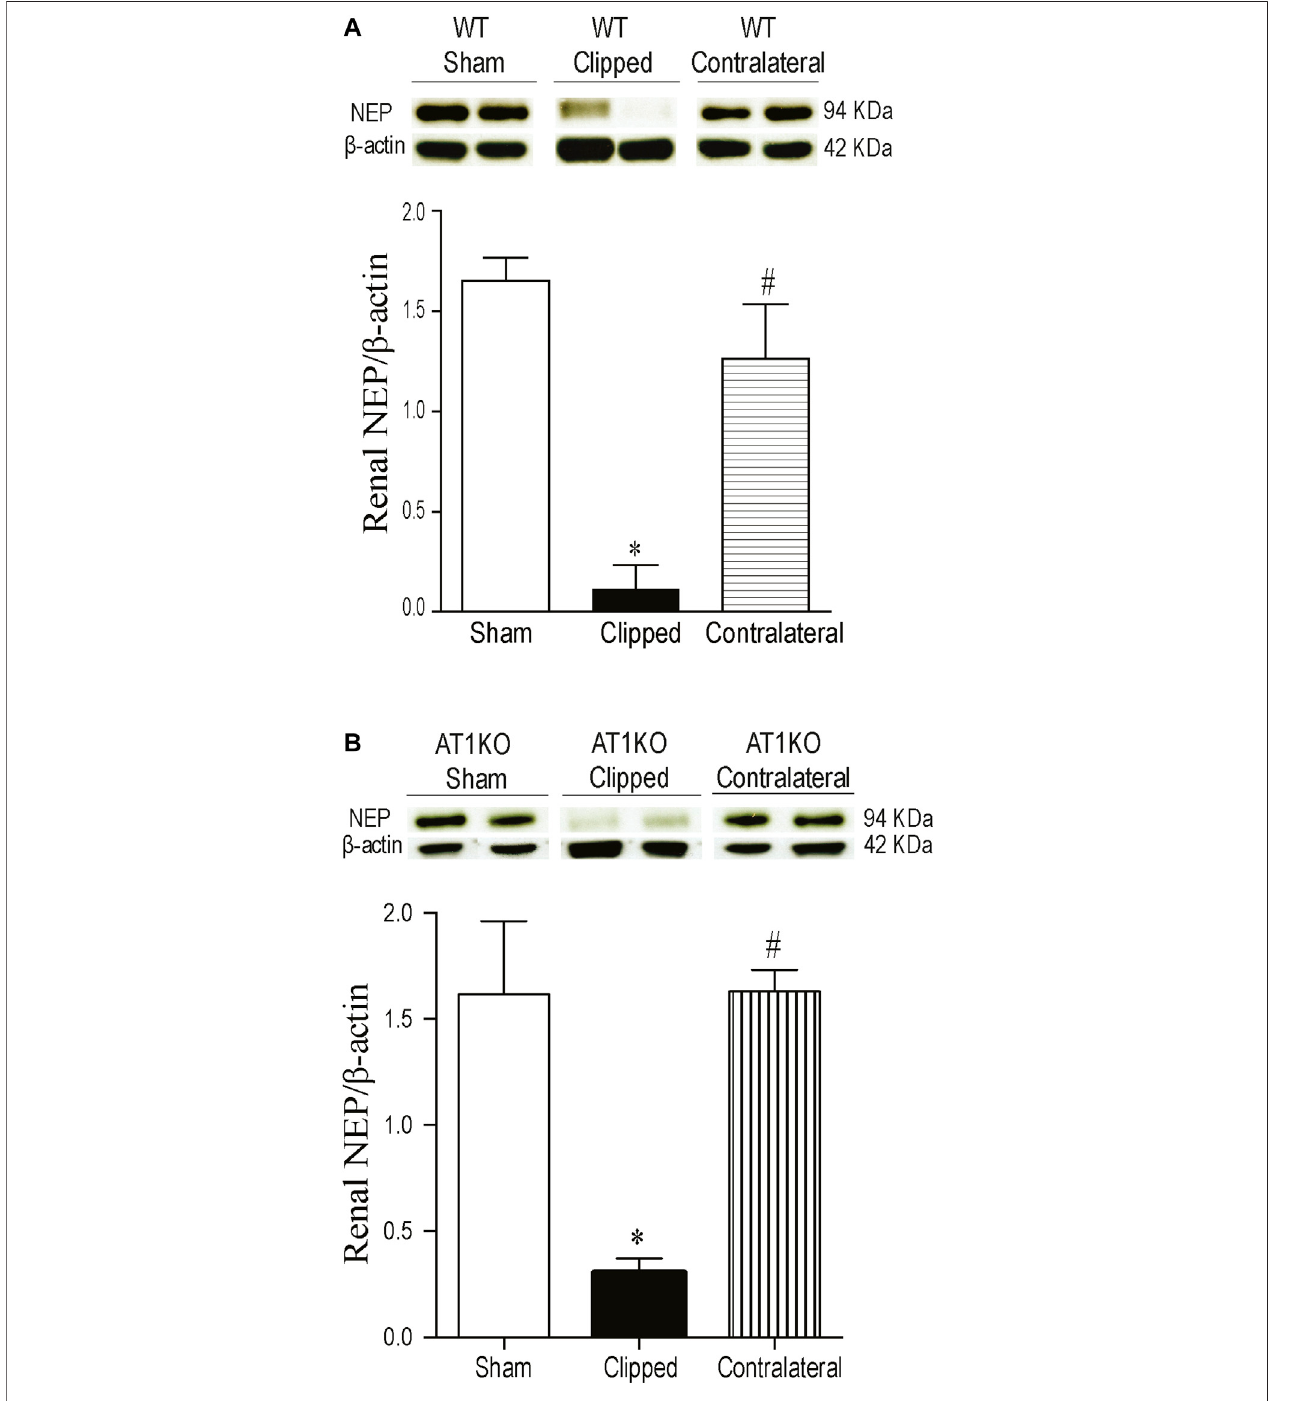
FIGURE 4 | Effect of renovascular hypertension on renal NEP expression in WT and AT1KO mice after 2 weeks of 2K1C Goldblatt surgery. (A) Renal NEP protein expression in WT sham, clipped and contralateral kidney. (B) Renal NEP protein expression in AT1KO sham, clipped and contralateral kidney. In each individual experiment, samples were loaded randomly in four gels. Two Immunoreactive bands from each group corresponding to NEP from this experiment were appropriately croppedandsplicedasarepresentativeoftheresult.One-wayANOVAshowedasigni fi cantdecreasedinrenalNEPexpressioninWTandAT1KOclippedkidneys compared to sham and contralateral kidneys (* p < 0.001 vs. sham, # p < 0.001 vs. clipped). Data are represented as mean ± SEM, (n (cid:2) 6).